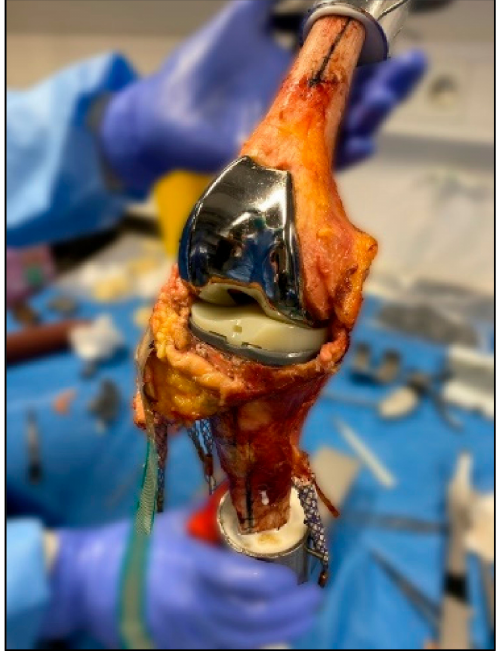
Figure 1. Human specimen after implantation of total knee prosthesis with an MS design (5C Medic, Implantcast GmbH, Buxtehude, Germany).